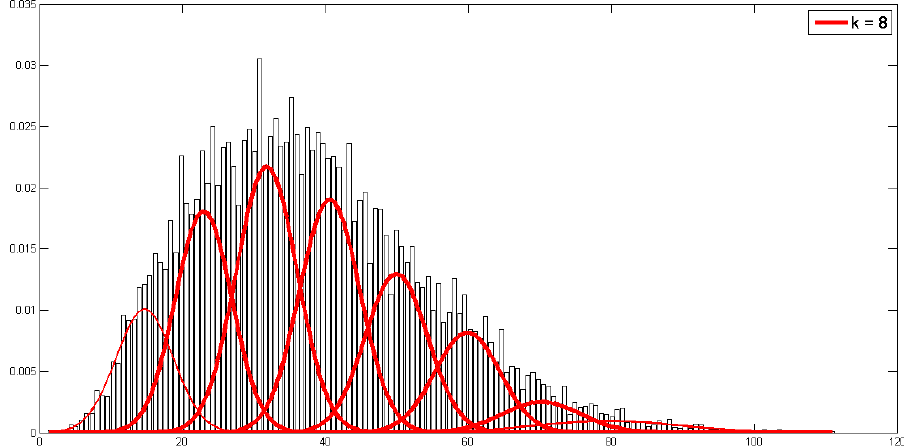
Figure 1. Results of the cluster analysis for concrete compressive strength f c , identification of eight different sub-classes. Table 1. Concrete compressive strength—statistical parameters 𝜇 and COV of the Gaussian Mixture Model (GMM) and probability of each component.